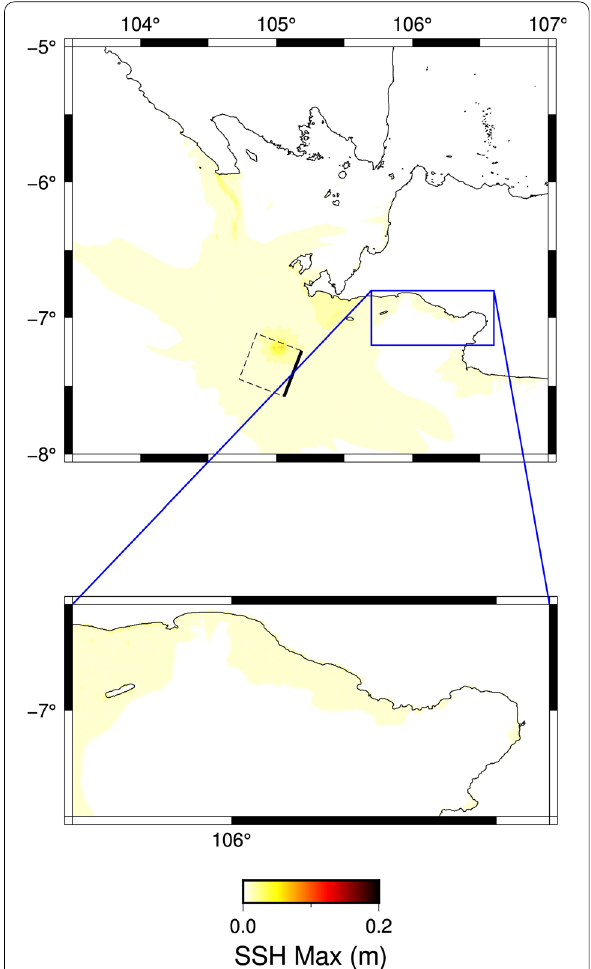
Fig. 6 The sea surface height maximum during simulation running for 2 h for a fault Model